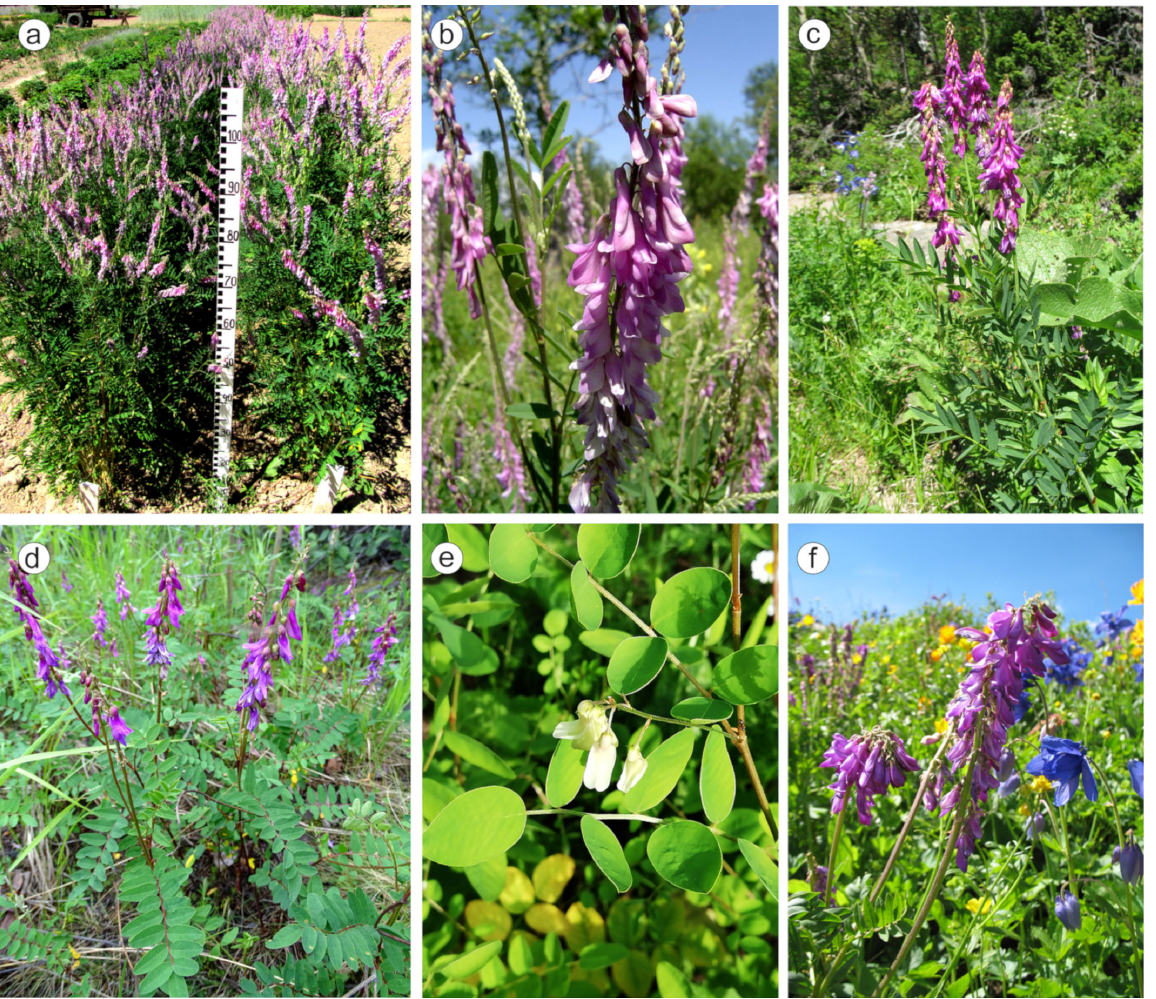
Figure 2. H. alpinum plants growing on the trial plot (AIMAP, Moscow) ( a ) and wild populations of H. alpinum (the Zabaikalye region) ( b ), H. theinum (the Altai Mountains) ( c ), H. hedysaroides (the Magadan region) ( d ), H. flavescens (AIMAP, Moscow) ( e ) and H. neglectum (the Altai region) ( f ). The photos were taken by S.I. Romashkina ( a , e ) and I.Yu. Selyutina ( b – d , f